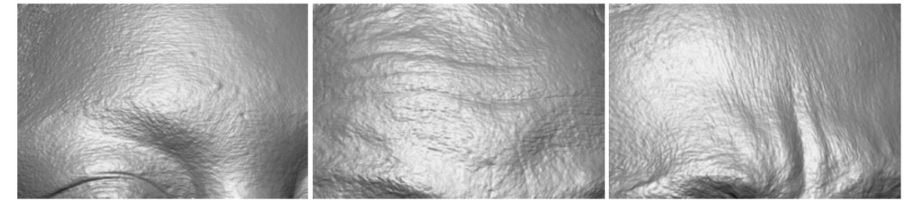
Figure 4. Fine detail recorded through capture technology